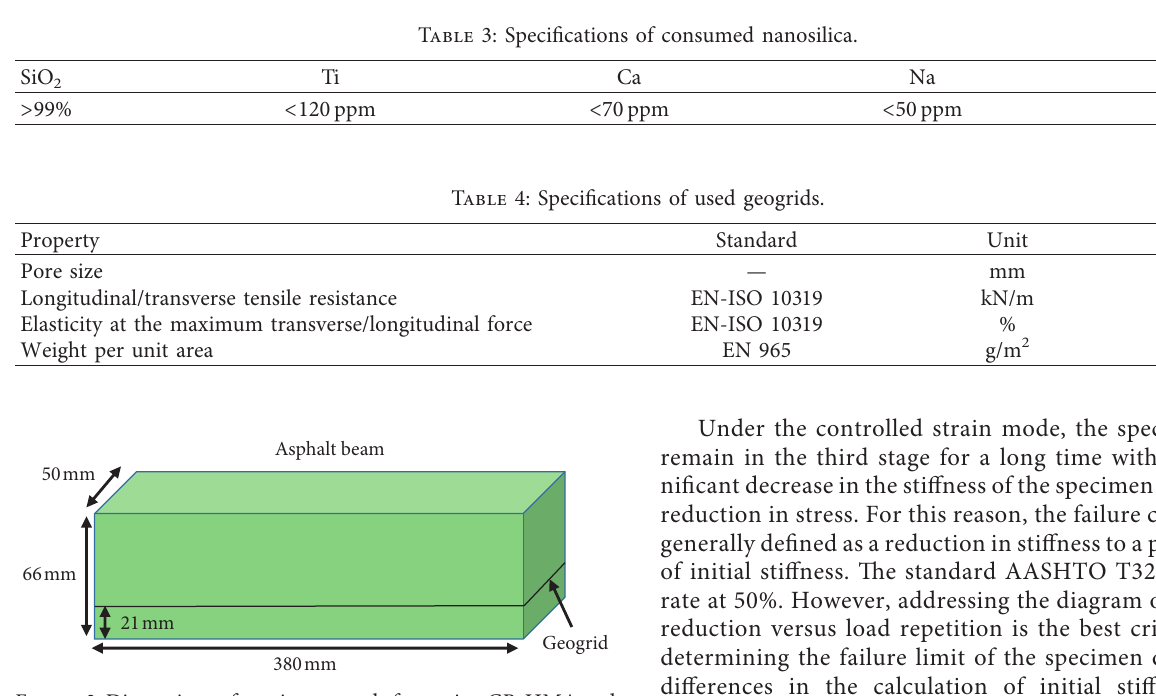
Figure 2: Dimensions of specimens made for testing GR-HMA and MRC-HMA